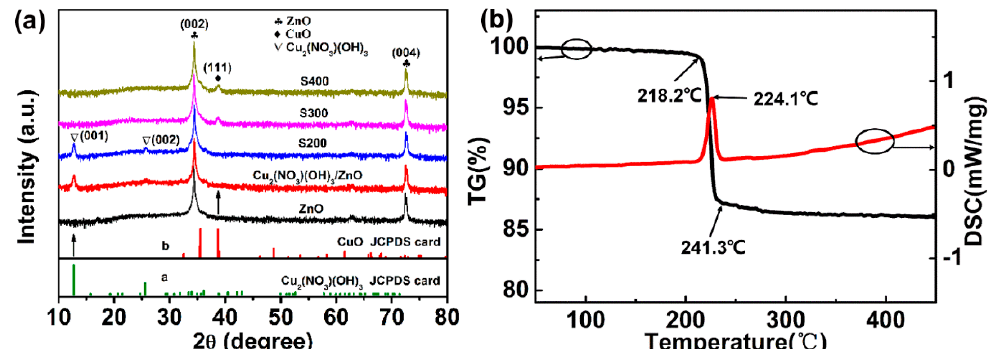
Figure 4. ( a ) XRD of the ZnO NRs, Cu 2 (NO 3 )(OH) 3 / ZnO NR precursor and Cu 2 (NO 3 )(OH) 3 / ZnO NRs annealed at 200, 300, and 400 °C. The reference patterns of Cu 2 (NO 3 )(OH) 3 (JCPDS card no. 45-0594) and CuO (JCPDS card no. 48-4548). ( b ) The TG-DSC analysis of the Cu 2 (NO 3 )(OH) 3 / ZnO NR precursor fabricated with 50 mM Cu 2+ ion concentration and 20 min UV illumination time.